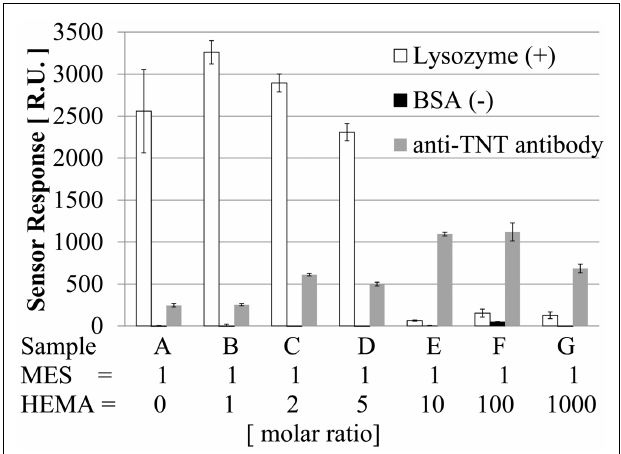
FIGURE 2 |Adsorption of lysozyme, BSA, and anti-TNT antibody .